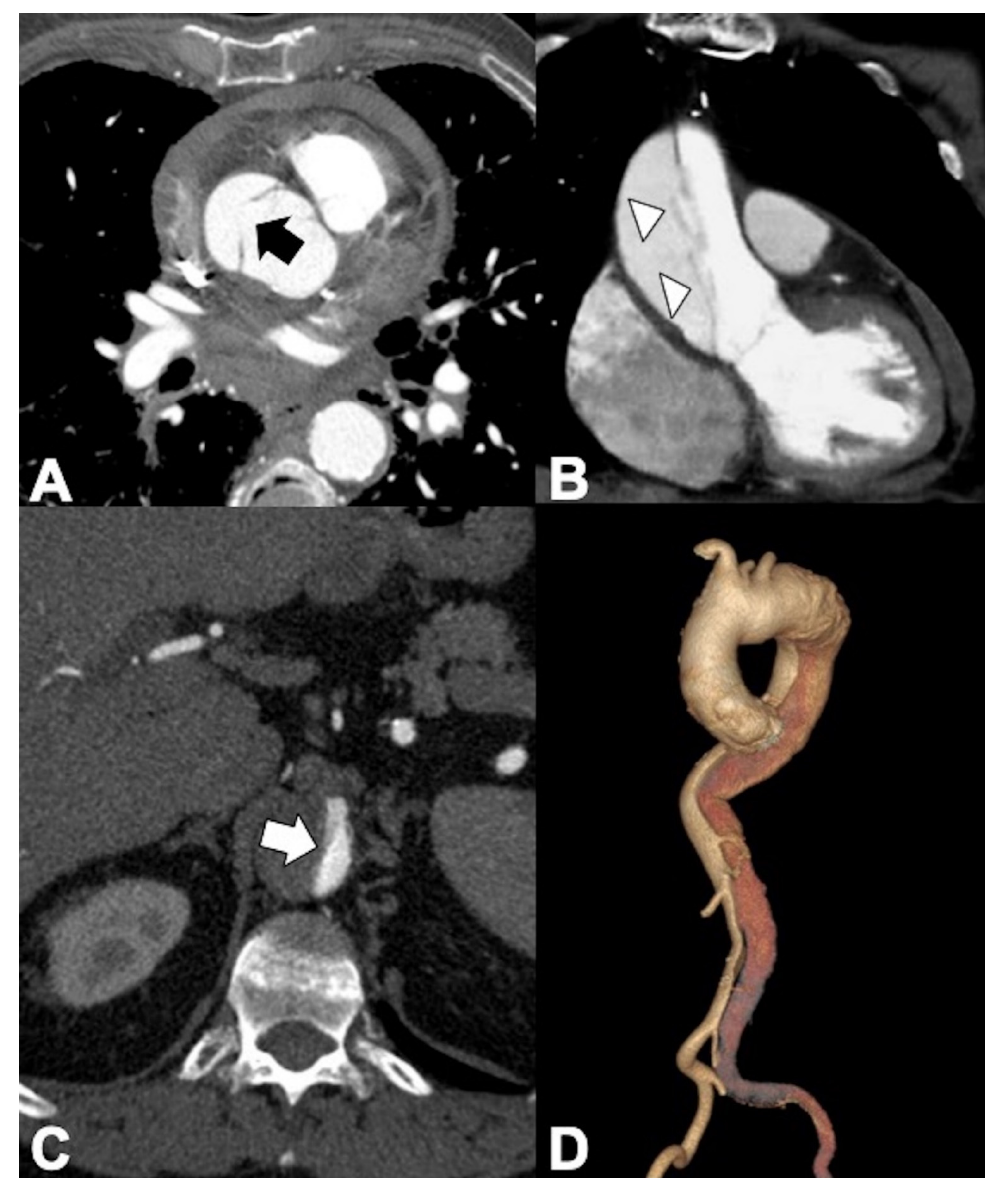
Figure 5. CTA findings in aortic dissection. ( A ) Axial CTA image showing intimomedial rupture sign in the ascending aorta (arrow) in type A dissection, indicating direction of the intimomedial entrance tear from true to false lumen. ( B ) Coronal CTA MPR image showing the intimomedial flap travelling parallel to the aorta long axis. Note the cobweb sign by thin, string-like filaments of the media layer in the false lumen (arrowheads). ( C ) Axial CTA image shows pressure competition between lumina and opacified true lumen collapse (arrow). ( D ) The different density of the TL (more intensely opacified due to faster flow) and FL in the early angiographic phase allows them to be clearly distinguished in the coronal VR reconstruction.